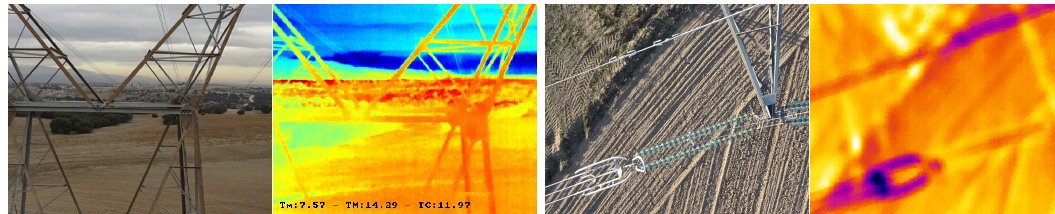
Figure 13. High voltage tower pictures, from left to right: optical-lateral, thermal-lateral, optical-zenit and thermal-zenit.